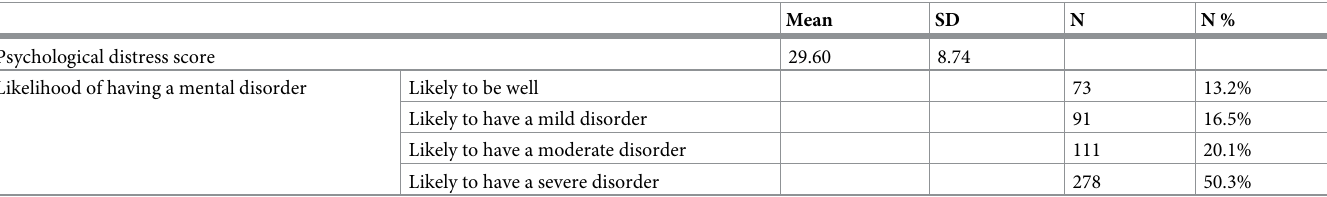
Table 5. Distribution of levels of mental disorders of the